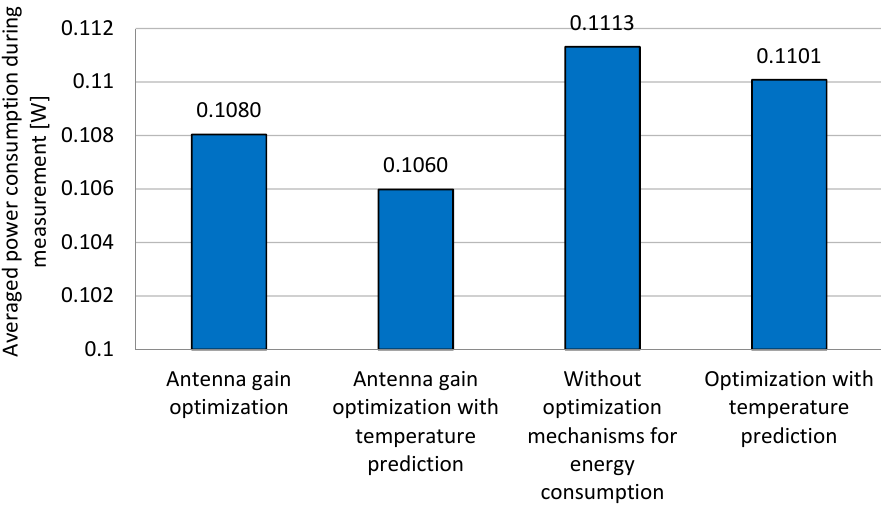
Figure 11. Graph of electricity consumption of the end device using antenna gain optimization and temperature prediction.